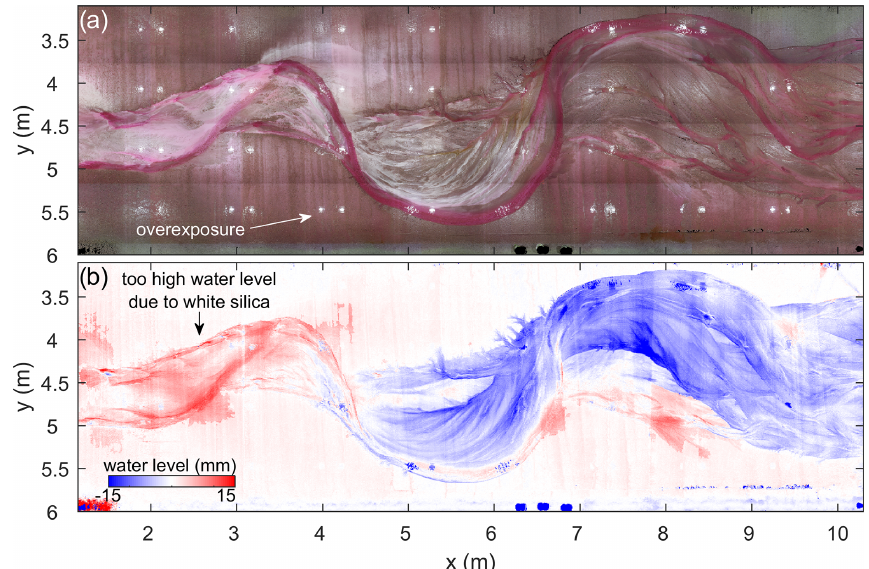
Figure 1. Exemplary data of a physical scale experiment of a meandering river by Van Dijk et al. (2013a) show how data extraction may be distorted. (a) Overhead imagery shows cases of light overexposure and the distribution of white silica flour. The water is dyed red where the water colour saturation is a measure of water depth. Flow is from left to right. (b) Water levels, based on measured bed elevations and water depths estimated from water colour saturation, are too high above the floodplain ( z = 0mm) at locations of abundant silica flour and too low at locations of